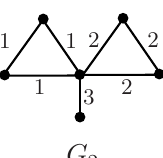
Figure 1. The graph G 2 with a strong proper